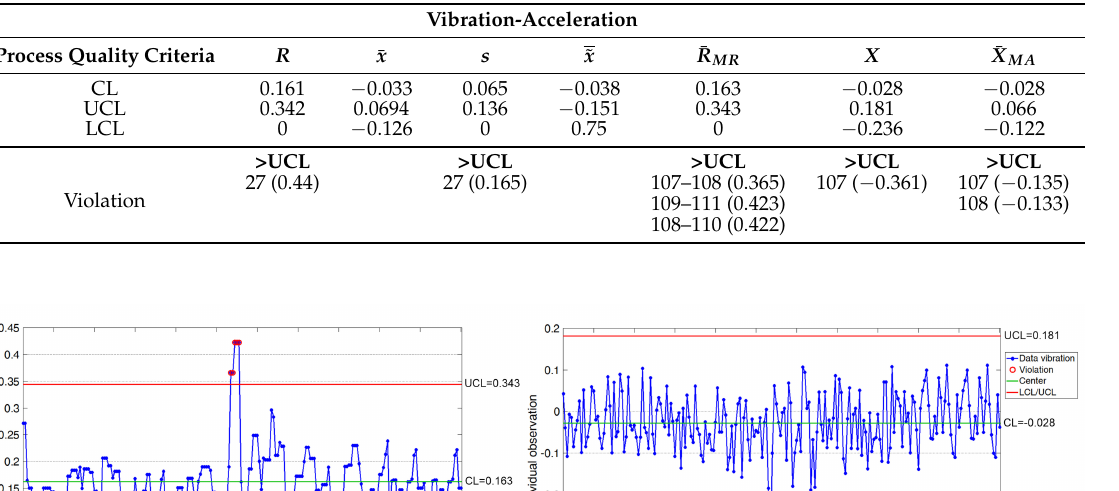
Table 11. Values of the center line and control limits for the vibration signal acceleration.